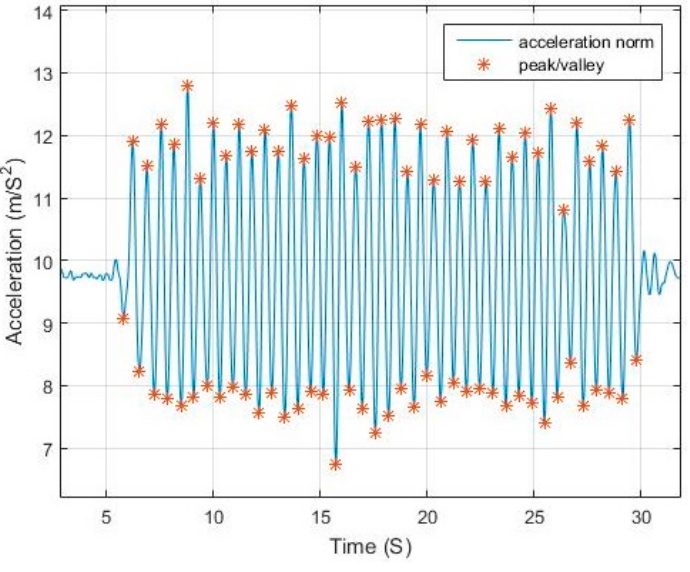
Figure 1. Walking sinusoidal pattern.